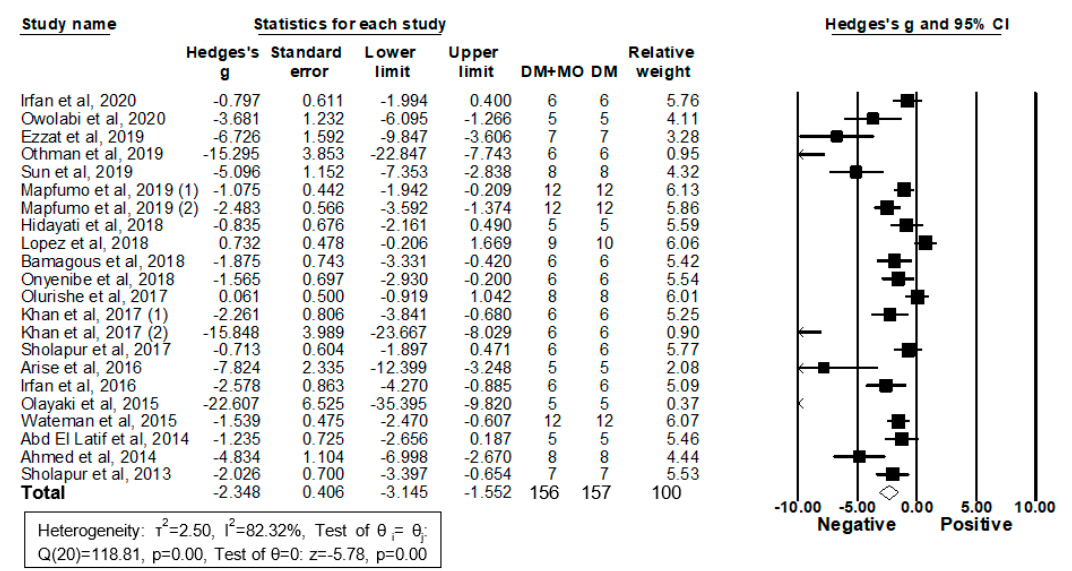
Figure 6. Meta-analysis of Hedges’ g of TC levels in DM rodents with and without treatment with MO. Summary estimates were analyzed using a random-effects model. CI, confidence interval.